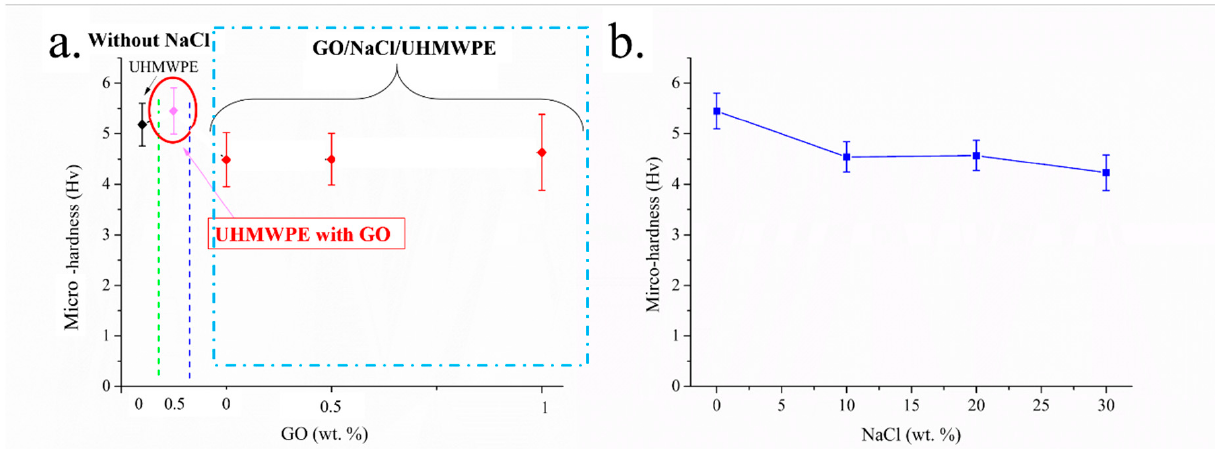
Figure 6. Influence of content of GO and NaCl on the UHMWPE hardness. ( a ) UHMWPE, UHMWPE with GO of 0.5 wt.%, UHMWPE with GO and NaCl (10 wt.%), ( b ) UHMWPE with GO of 1 wt.% with different content of NaCl.